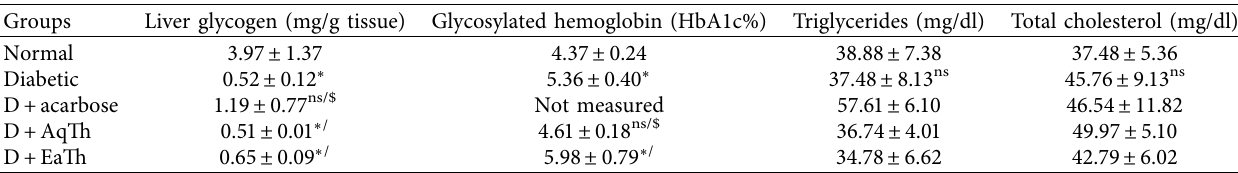
Table 3: Effect of 200mg/kg AqTh, 50 mg/kg EaTh, and 10mg/kg acarbose on liver glycogen, glycosylated hemoglobin, triglyceride, and total cholesterol in STZ-induced diabetic rats after 4-week treatment.